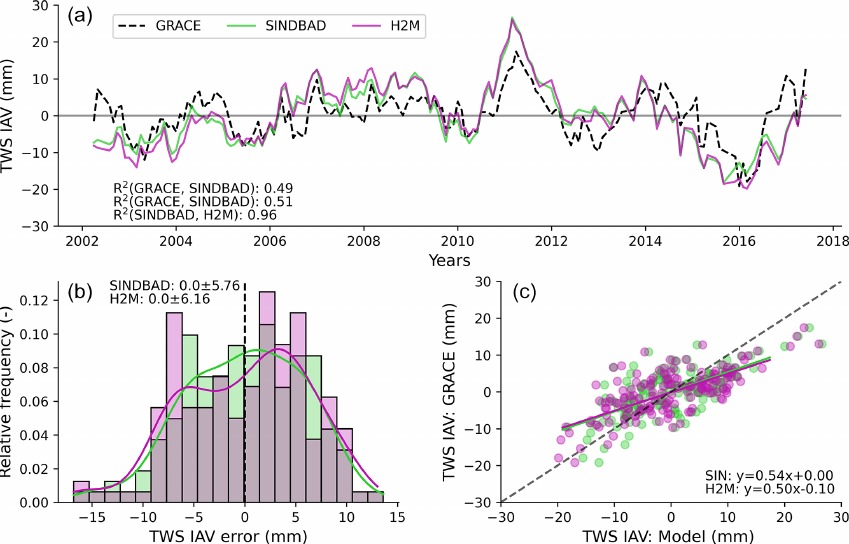
Figure 2. Comparison of monthly global terrestrial water storage (TWS) interannual variability (IAV) from GRACE observations and two data-driven hydrological models (SINDBAD and H2M). (a) Time series comparison of monthly global TWS IAV. R 2 statistics in the bottom left are calculated as the square of the Pearson correlation coefficient. (b) Histogram of errors in the global TWS IAV (Eq. 3), with smoothed kernel density curves estimated using the Gaussian kernel and Scott’s rule of thumb to determine the bandwidth of the kernel. The sum of all bar heights (different models in different colors) equals unity. The text shown in the upper left is the mean ± standard deviation of the distribution of each model. (c) Scatterplot of monthly TWS IAV by GRACE and models. Equations in the bottom right are from a robust linear regression using Huber’s (https://doi.org/10.1002/0471725250) T estimation for down-weighting